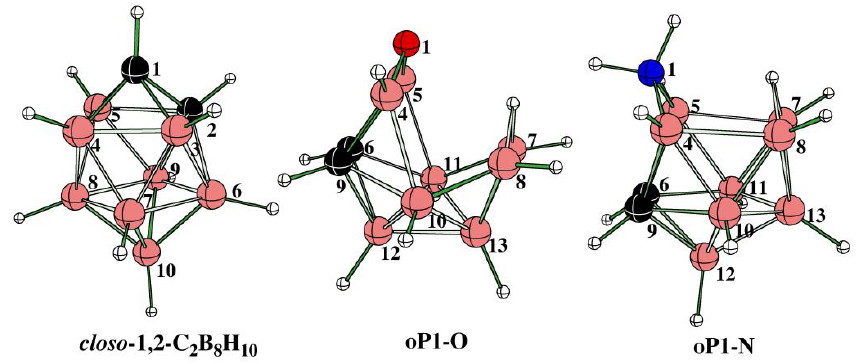
Table 1. Solvation free energies (kcal.mol −1 ), and free energies relative to the appropriate reference. The small “o” refers to ortho (1,2-) C 2 B 8 H 10 . The capital letters “ A ”, “ B ”, “ C ”, etc. and “TS#”